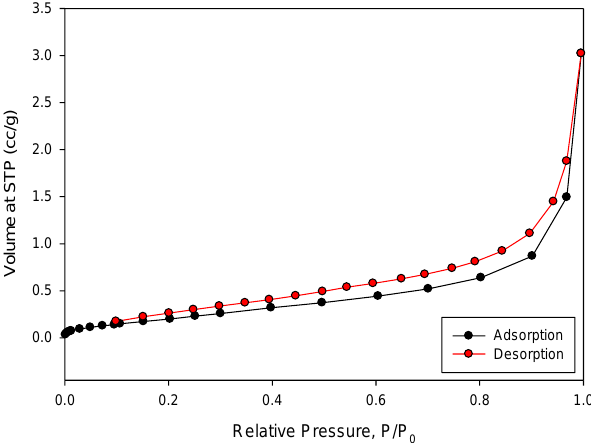
Figure 2. BET adsorption isotherm curves of the SCM beads.